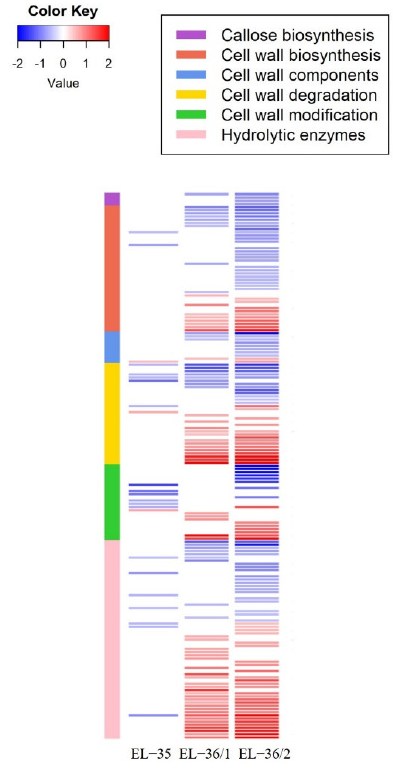
Figure 3. Genes differentially expressed during the progression of the berry shrivel symptoms in ripening berries belonging to the cell wall metabolism are represented in a heatmap. Values are presented as the log 2 FC (BS/H) at EL-35, EL-36/1, and EL-36/2. Blue and red colors indicate down- and up-regulation in BS, respectively. A white cell denotes the non-significance. The colored sidebar on the left indicates their functional groups.